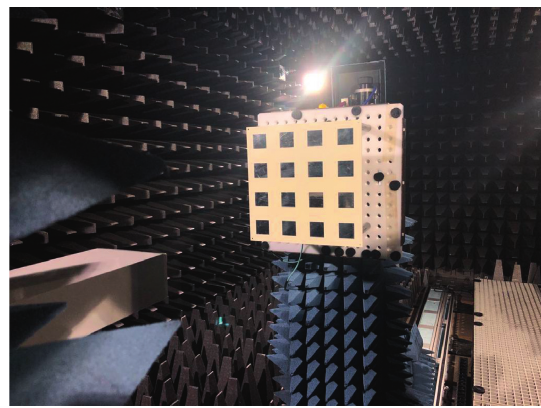
Figure 8: 4 × 4 array used for demonstration of the outspacing concept in the anechoic test